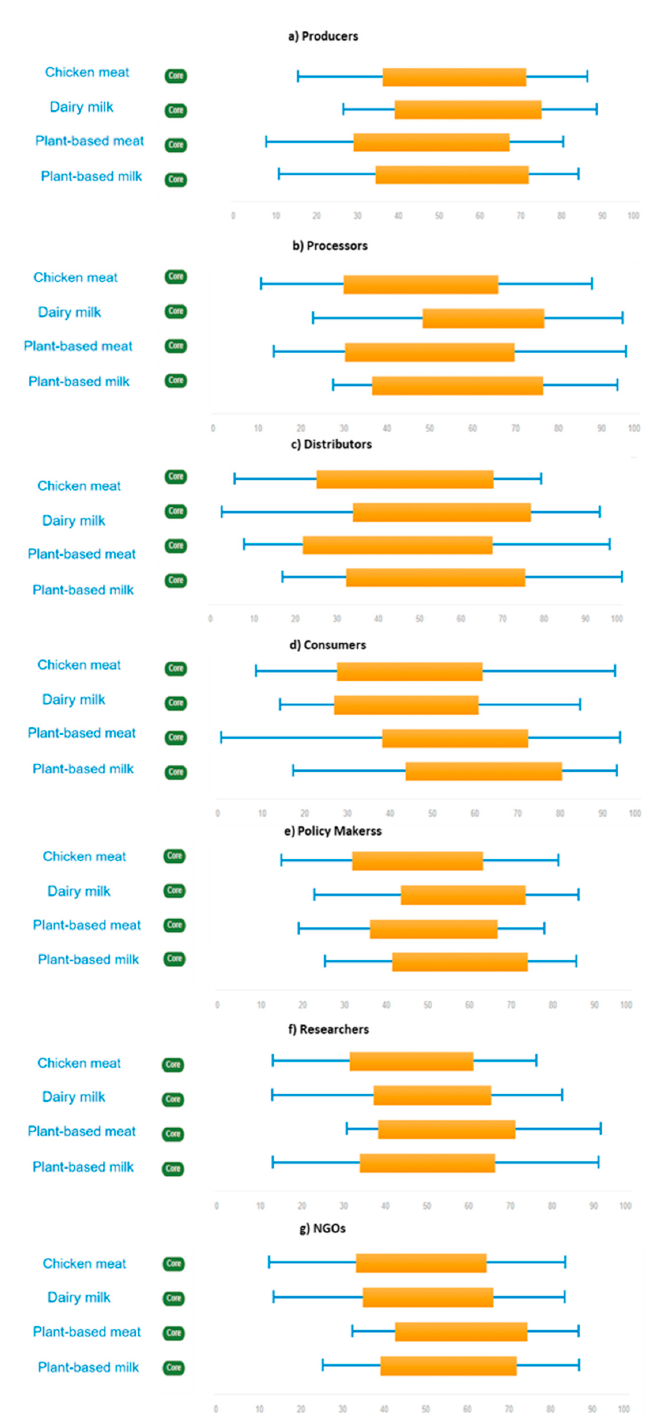
Figure A1. Overall ranking of food products by stakeholder group: ( a ) Producers; ( b ) Processors; ( c ) Distributors; ( d ) Consumers; ( e ) Policy-makers; ( f ) Researchers; and, ( g ) NGOs e. Solid orange bars show rank means (the left and right ends indicate the means of the low and high ranks assigned by each stakeholder). Thin blue lines refer to rank extremes (the left and right ends indicate the lowest and highest ranks assigned by any stakeholder).